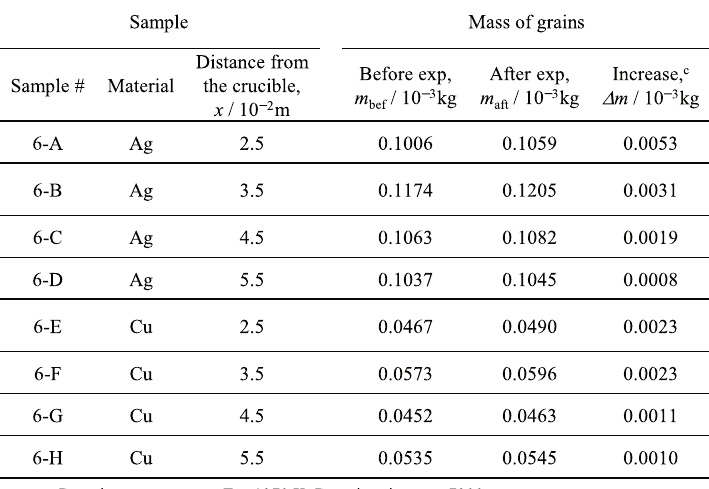
Table 8. Analytical results of the silver and copper grains set in the reaction tube. a,b